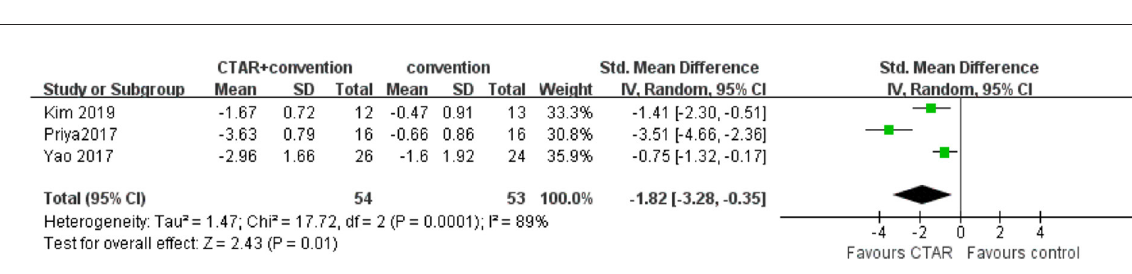
FIGURE4 Pooled changes of oral intake ability in CTAR exercise vs. no exercise intervention.